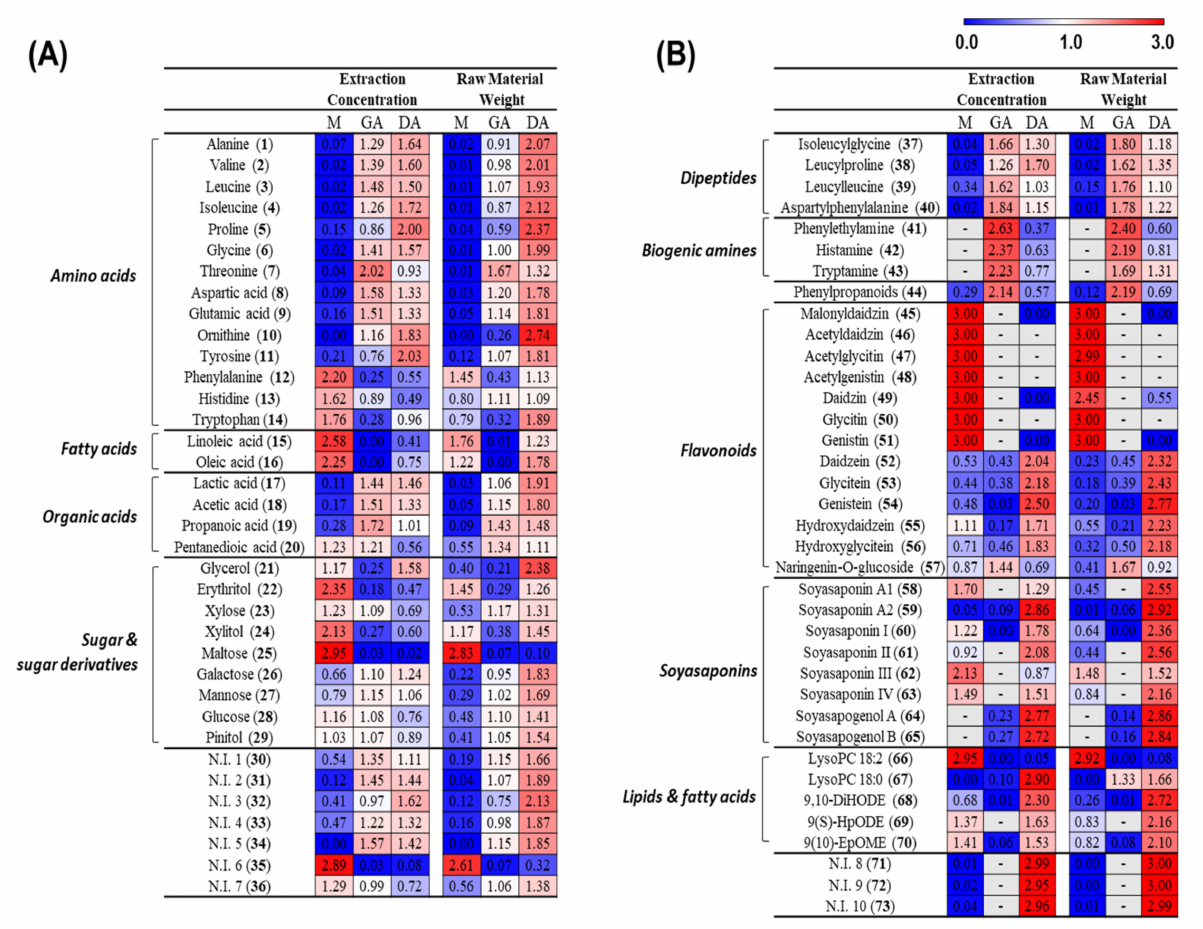
Figure 3. Heat map derived from GC-TOF-MS ( A ) and UHPLC-Orbitrap-MS/MS ( B ). A heat map includes data based on extract concentration and normalized raw material weight. The values represent fold changes by an average peak area of each metabolite (Variable importance in projection (VIP) >